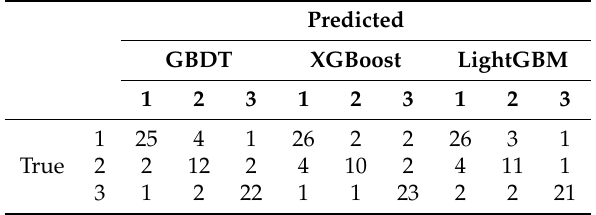
Table 4. Prediction results of each algorithm.